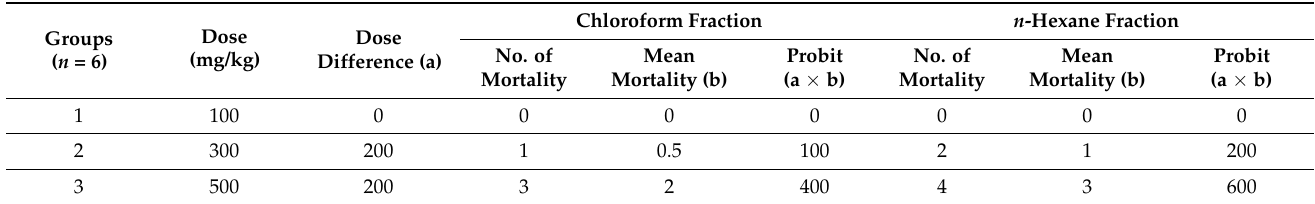
Table 8. Acute toxicity assay of X. spinosum chloroform and n -hexane fractions in mice. Dose Groups ( n = 6)